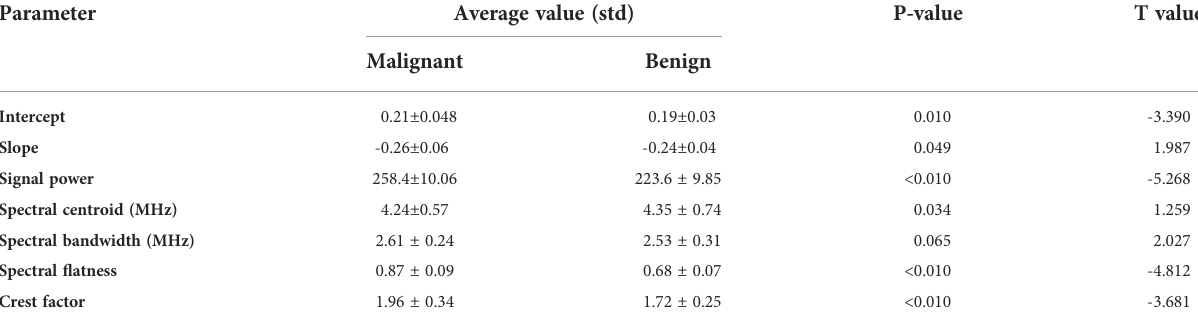
TABLE 3 T-test results to prove the statistical signi fi cance between malignant and benign classes.